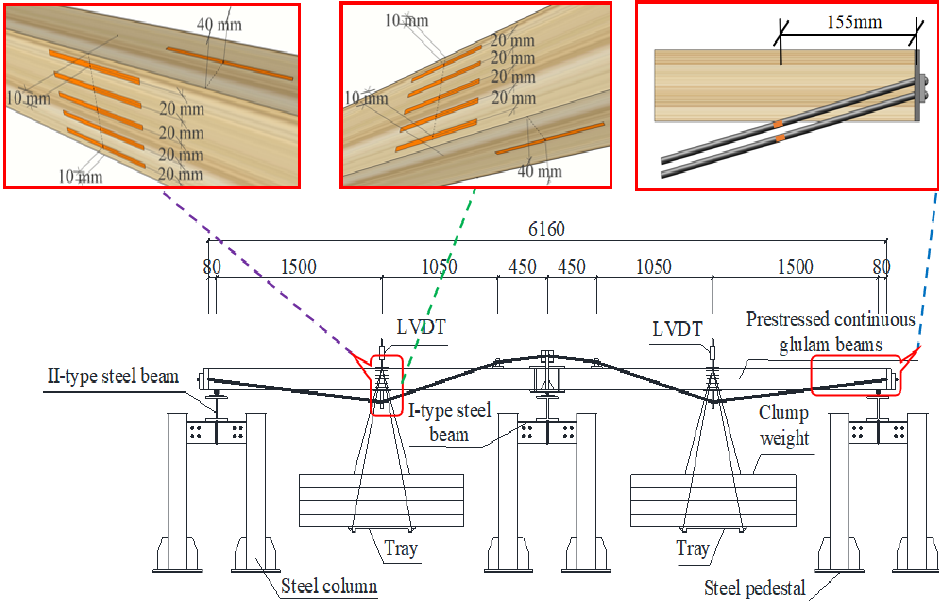
Figure 6. Test setup and measuring point layout of the long-term loading test.